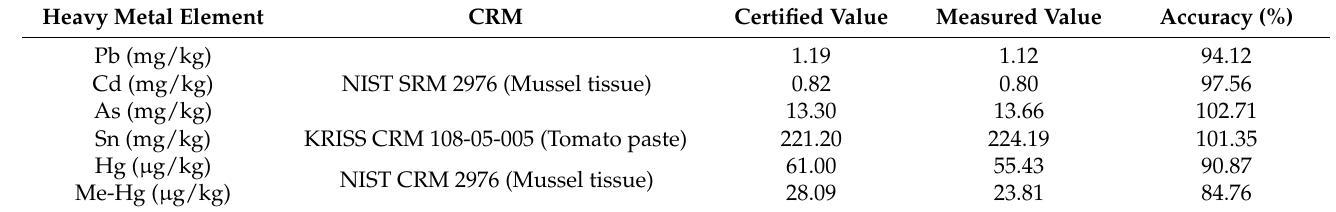
Table 4. Comparisons of the certified and measured values of six heavy metals in the CRM (accuracy).